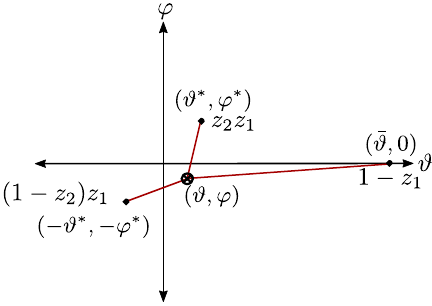
Figure 6 . The three-particle con(cid:12)guration consists of a pair of particles and a third particle that is far away, due to the strong angular ordering. We also show the position of a test broadening axis, and indicate the angular distances (with red lines) that determine the broadening. The origin of the coordinate system is chosen to lie between the two nearby particles and the # axis is chosen such that the third particle lies on